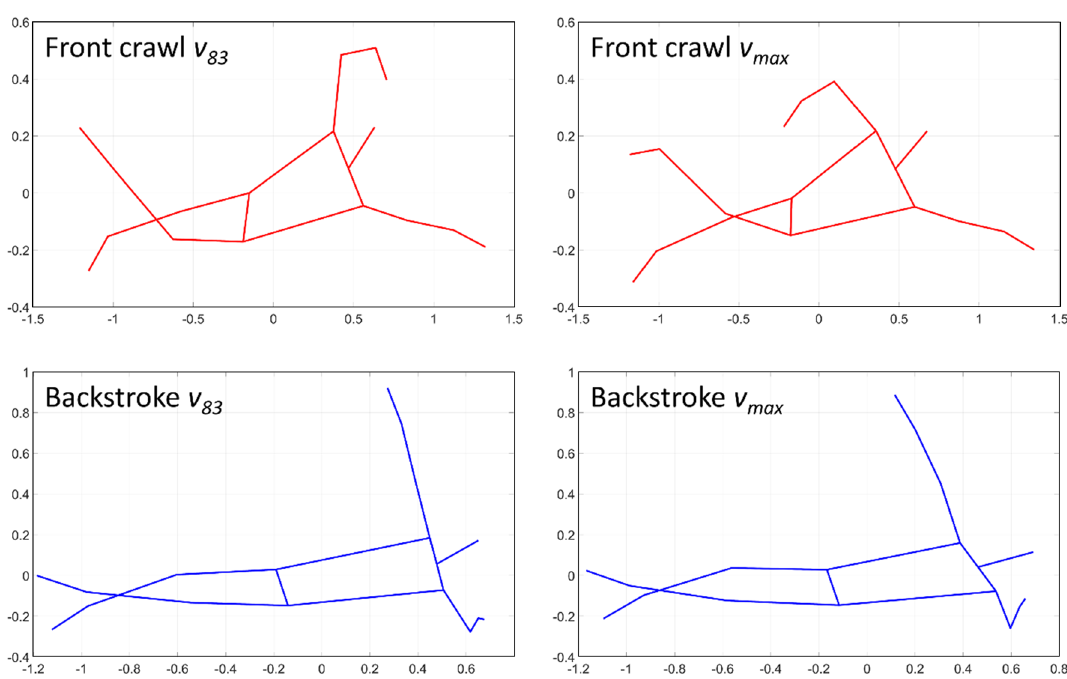
Figure 7. Side-view stick figure of a participant when he exhibited hip roll peak at v 83 and v max